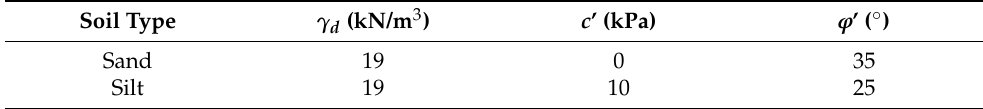
Table 5. Main physical and mechanical properties of the materials in Section 4.2.